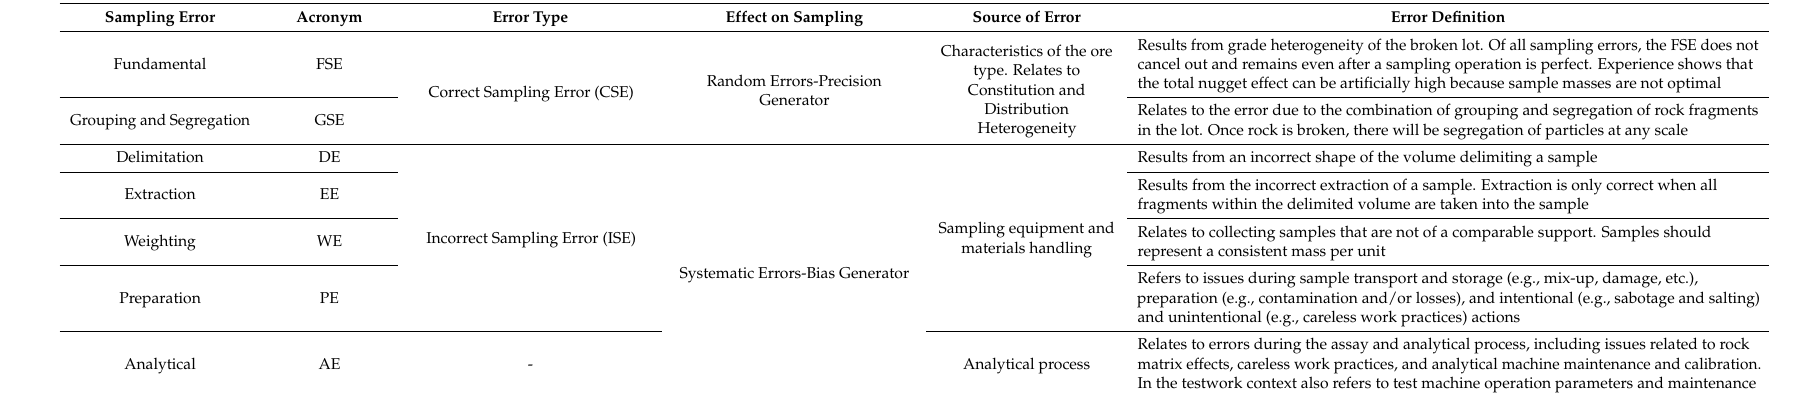
Table 3. Definition of key TOS errors.